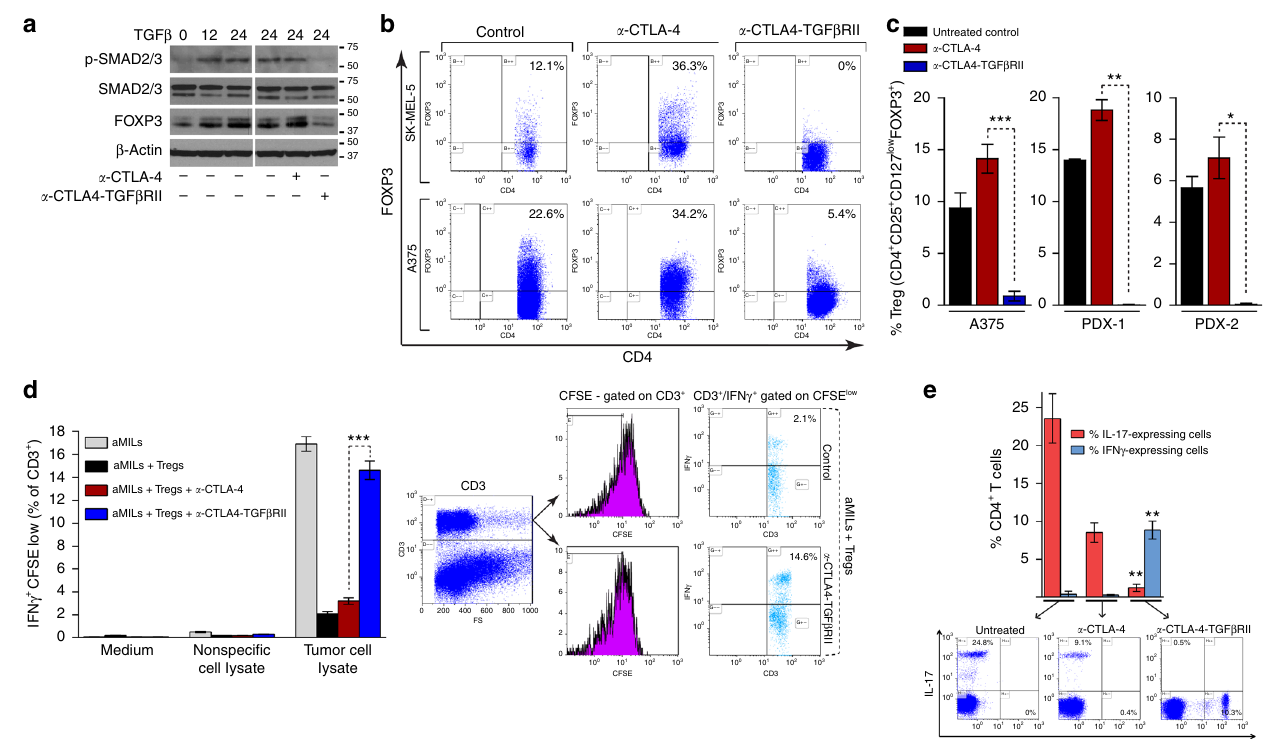
Fig. 3 a -CTLA4-TGF β RII counteracts tumor-in fi ltrating Tregs and inhibits T H 17 differentiation. a Immunoblot analyses of the effect of a -CTLA4-TGF β RII or a -CTLA-4 on TGF β -induced SMAD-2/3 phosphorylation and expression of FOXP3 in human PBMC. PBMCs were cultured for 24 – 48 h with rhIL-2 (100 IU ml − 1 ) and anti-CD3/anti-CD28-coated Dynabeads in the presence or absence of rhTGF β 1 (2.5 ng ml − 1 ) with or without either a -CTLA4-TGF β RII or a - CTLA-4 (5 μ g ml − 1 ). b , c Flow cytometric analysis of the in vivo effect of a -CTLA4-TGF β RII or a -CTLA-4 on bone marrow (BM) and tumor-in fi ltrating Tregs in human melanoma tumor-bearing NSG mice that were immune reconstituted with tumor-matched HLA A2 + human CD34 + bone marrow cells. Mice engrafted with human CD3 + cells were inoculated subcutaneously with either human melanoma tumor cells (A375 or SK-MEL-5) or patient-derived melanoma tumor xenografts (PDX-1 and PDX-2). Tumor-bearing mice (A375; SK-MEL-5; PDX-1; PDX-2) were randomized into groups and treated with either a -CTLA4-TGF β RII or a -CTLA-4 (5 mg kg − 1 i.p. weekly), or vehicle alone (untreated control). b Representative fl ow data of FOXP3 expression in BM CD4 + CD25 + T cells in A375 or SK-MEL-5 tumor-bearing mice from each treatment or control group. c The percentage of Tregs (CD4 + /CD25 high / CD127 low /FOXP3 + ) in tumor-in fi ltrating lymphocytes in A375- or PDX-bearing mice ( fi ve animals per treatment group for A375 and four mice for PDXs). d Effect of a -CTLA4-TGF β RII or a -CTLA-4 on the suppression of tumor-reactive T cells by autologous Tregs in tumor-in fi ltrated BM from a patient. Marrow- in fi ltrating lymphocytes (MILs) stimulated with anti-CD3/anti-CD28-beads and rhIL-2 were carboxy fl uorescein N-hydroxysuccinimidyl ester (CFSE) labeled and added to autologous BM that had been pulsed with either myeloma cell lysate (tumor-speci fi c antigen) or nonspeci fi c antigen in the presence or absence of autologous CD4 + /CD25 + MILs, with or without either a -CTLA4-TGF β RII or a -CTLA-4 (5 μ g ml − 1 ) for 3 days. Tumor antigen-reactive T cells (CD3 + /CFSE low /IFN γ + ) were quanti fi ed by fl ow cytometry (three in vitro replicates for each experimental group). e PBMCs were stimulated with anti- CD3/CD28 beads in the presence of IL17-skewing cytokines (10 ng ml − 1 IL-6, 5 ng ml − 1 TGF β , 10 ng ml − 1 anti – IFN- γ , and 10 ng ml − 1 anti – IL-4) with or without either a -CTLA4-TGF β RII or a -CTLA-4 (5 μ g ml − 1 ) for 3 days. Following addition of Leukocyte Activation Cocktail (2 μ l ml − 1 for 4 h), cells were analyzed by fl ow cytometry for intracellular expression of IL-17 and IFN- γ in CD4 + T cells (three in vitro replicates for each experimental group). Asterisks represent statistical signi fi cance between the a -CTLA4-TGF β RII and a -CTLA-4 treatments. Representative fl ow cytometric dot plots are